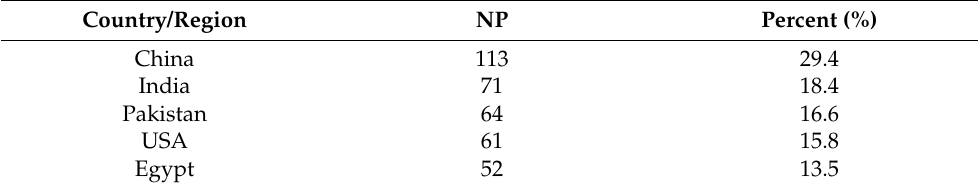
Figure 2. A globe map showing the contribution of each country/region based on the number of publications. Table 3. The top five countries/regions that published papers regarding NPs enhancing abiotic tolerance in plants from 2008 to